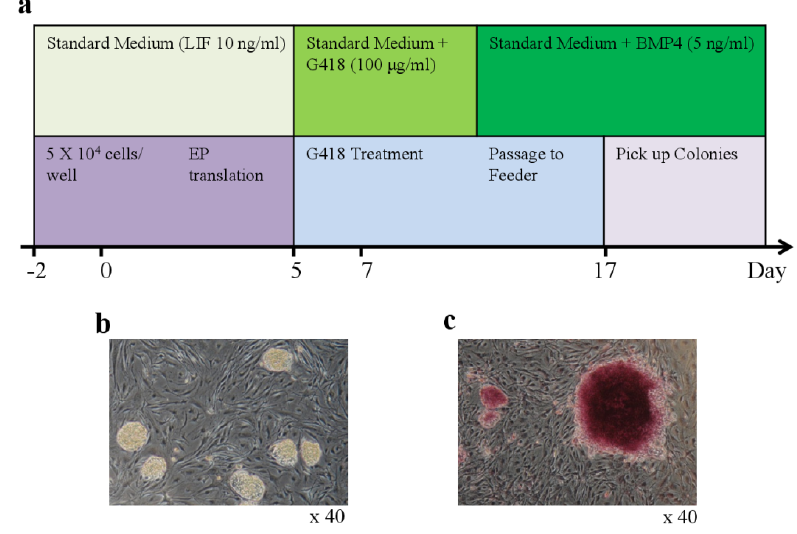
Table 1. Summary of the characteristics of stemness gene expression and pluripotency. The results of the immunocytochemical analysis of pluripotency and surface markers and RT-PCR analysis of transcripts of the “stemness” genes (encoding OCT4, SOX2, c-MYC, KLF4, STAT3, SUZ12, DNMT1, and MEF2A) in bovine testis cells and iPSCs are